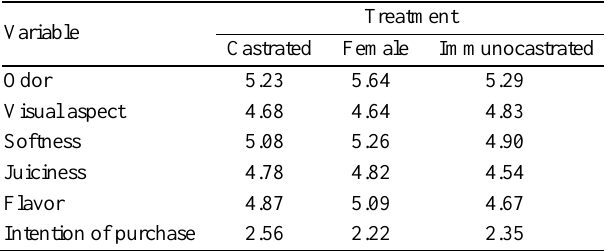
Table 4. Lightness (L*), redness (a*), yellowness (a*) and shear force (SF) of the muscle longissimus dorsi of male Table 6. Sensorial parameters and intention of purchase immunocastrated, surgical castrated and female pigs Treatment Variable